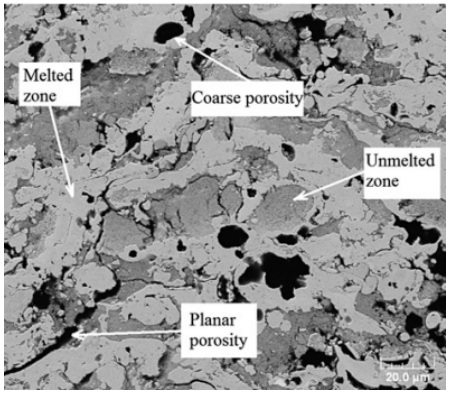
Figure 11. SEM cross-sectional microstructure of Ni-YSZ by APS. Reproduced with permission from [42], Elsevier, 2008.